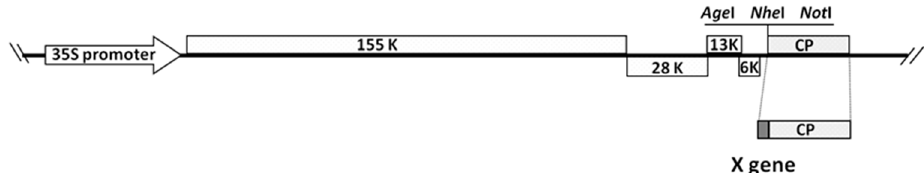
Figure 1. Schematic representation of the recombinant constructs based on the bamboo mosaic virus-based (BaMV) genome. pBS-d35CP is a mutant infectious construct of BaMV with N-terminus of the 35 amino acids truncated coat protein (CP) under the control of cauliflower mosaic virus 35S promoter. The restriction enzyme recognition sites for cloning are indicated on top.